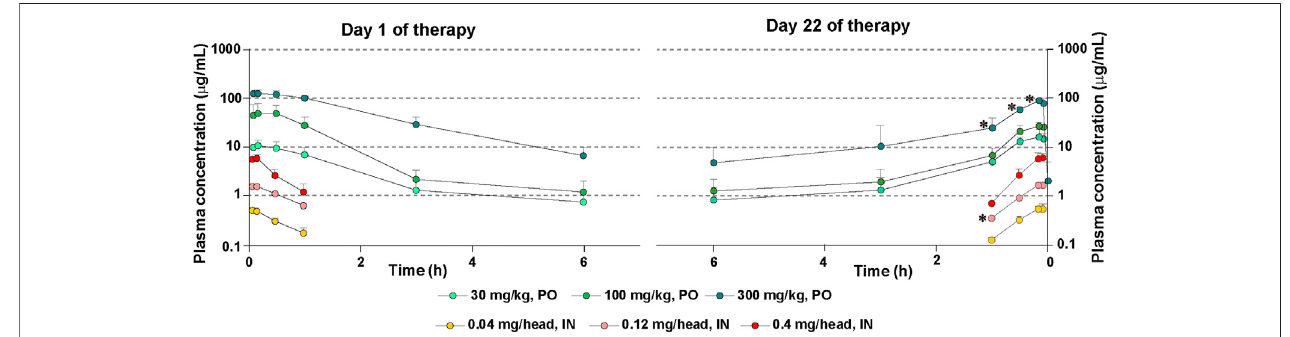
FIGURE 7 | Plasma levels of PFD after repeated administrations of PFD by the oral or intranasal route. Human transforming growth factor (TGF) β 1 transgenic (TG) mice were allocated in groups treated with PFD by oral ( n (cid:2) 4) or intranasal ( n (cid:2) 4) administration and blood samples were drawn from each group on day 1 and day 22. Bars indicate the mean ± S.E.M. Statistical analysis by Student ’ s t -test with Welch ’ s correction. * p < 0.05.